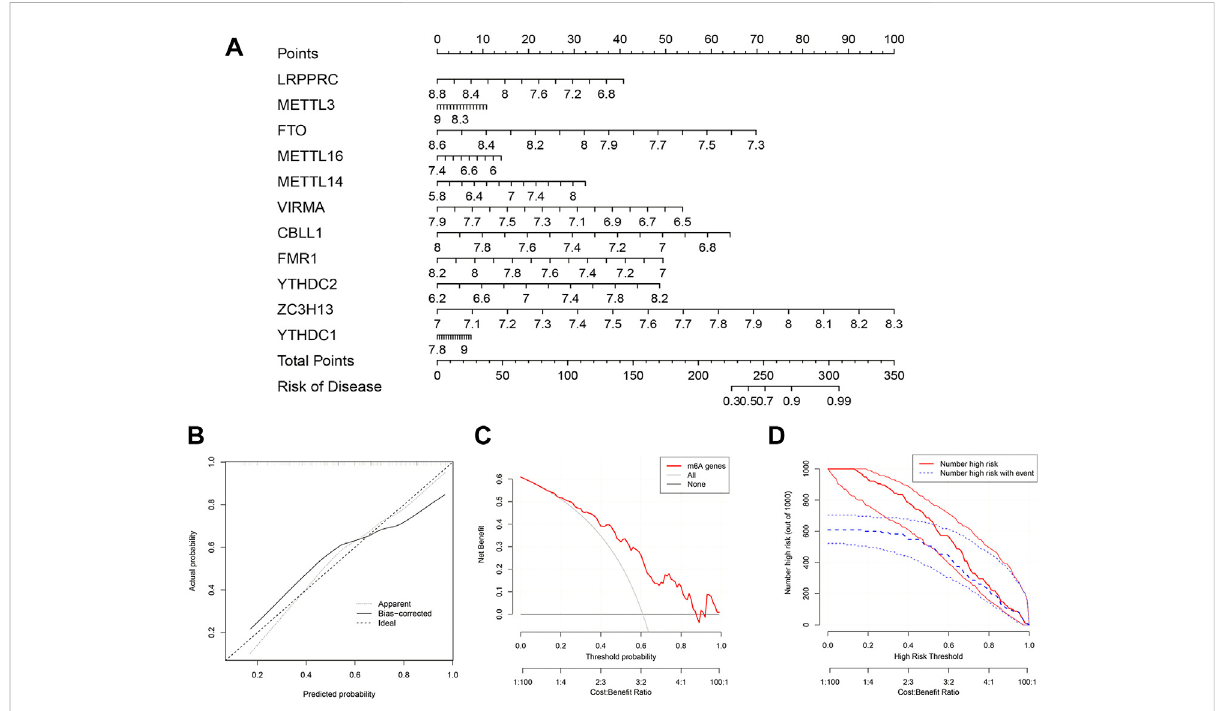
FIGURE 5 Construction of the nomogram model. (A) Nomogram model constructed by the 11 candidate m6A regulators. (B) Predictive value of nomogram model throughacalibrationcurve. (C) Decisions curveanalysis of nomogram modelshowingbene fi tsto IPFpatients. (D) Clinical impact curve of nomogram